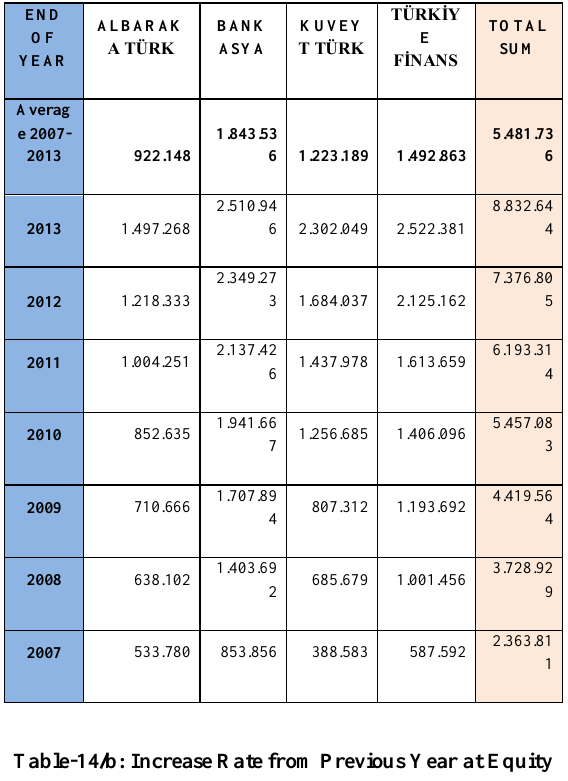
Table-14/a: Growth of Equity Capital, 2007-2013 (1000TL)